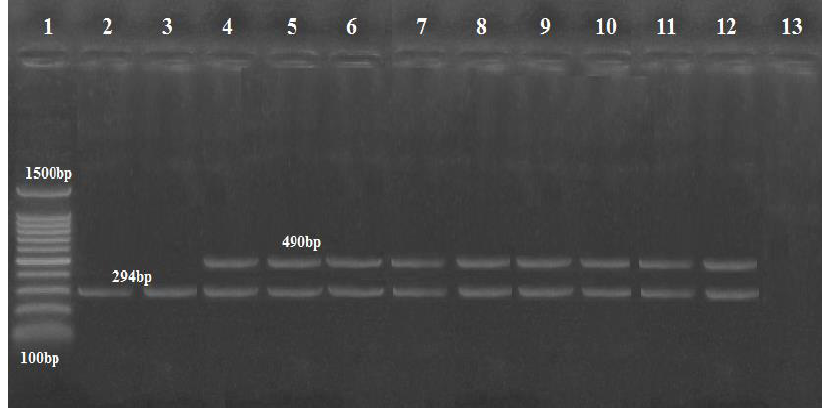
Figure 1. Agarose gel image showing Acinetobacter isolates differentiated by multiplex PCR using gyr B - primers. Lane: DNA Marker (100 bp ladder Gold Bio Company, Cat.D001, US) lanes (4 – 12) were A. baumannii at 490 bp; lanes (2 and 3) were Acinetobacter genomic sp. 13TU (394 bp); lane 13: negative control with no DNA template.